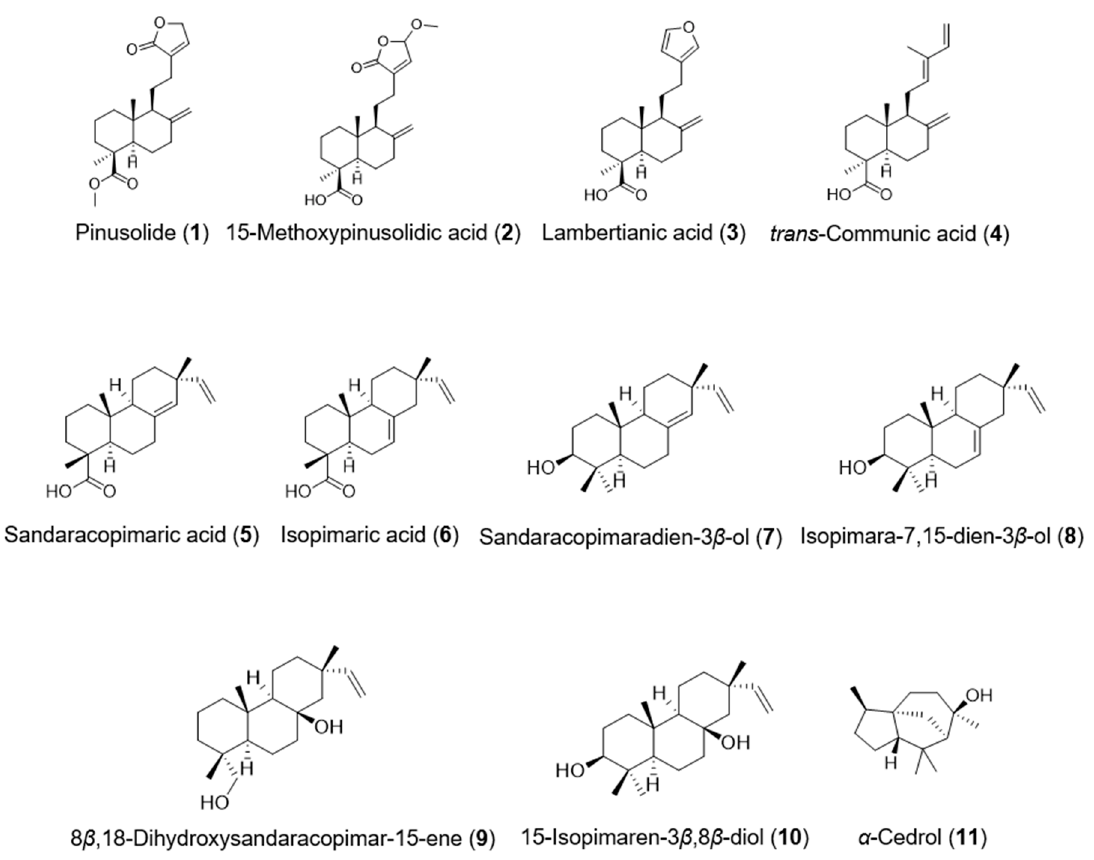
Figure 1. Chemical structures of compounds 1 – 11 isolated from Platycladus orientalis . Compound 1 (pinusolide). 1 H NMR (CDCl 3 , 500 MHz,): δ H 7.09 (1H, p , J = 1.7